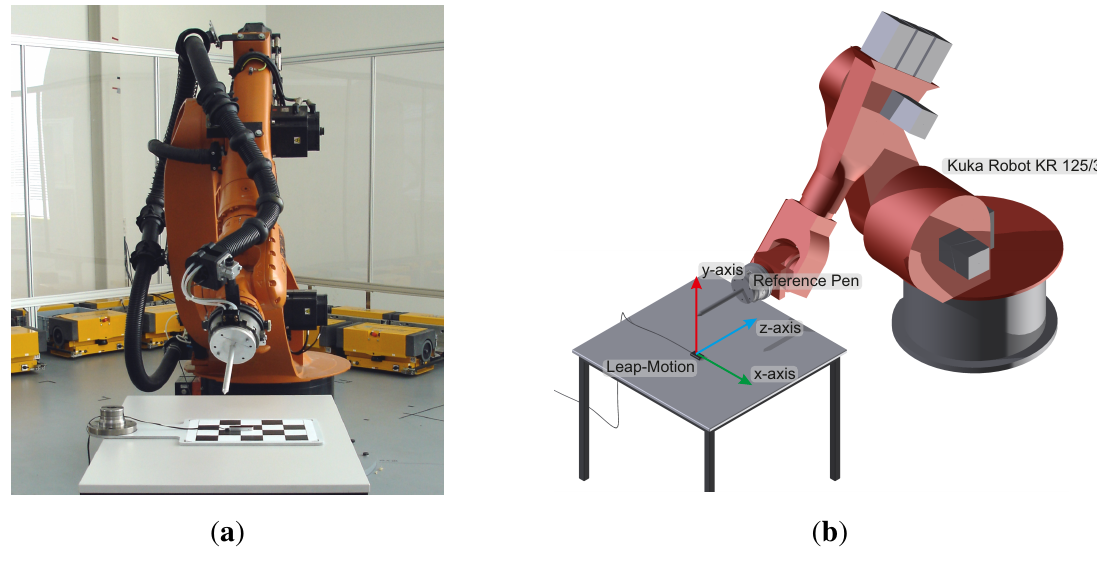
( b ) Schematic View with a Coordinate